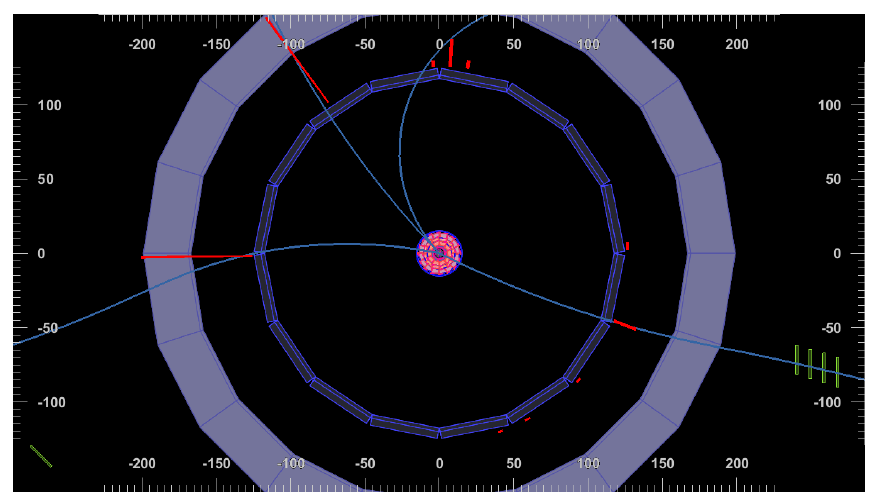
Figure 3: Event display of the Belle II detector showing a 3-1 prong event, likely